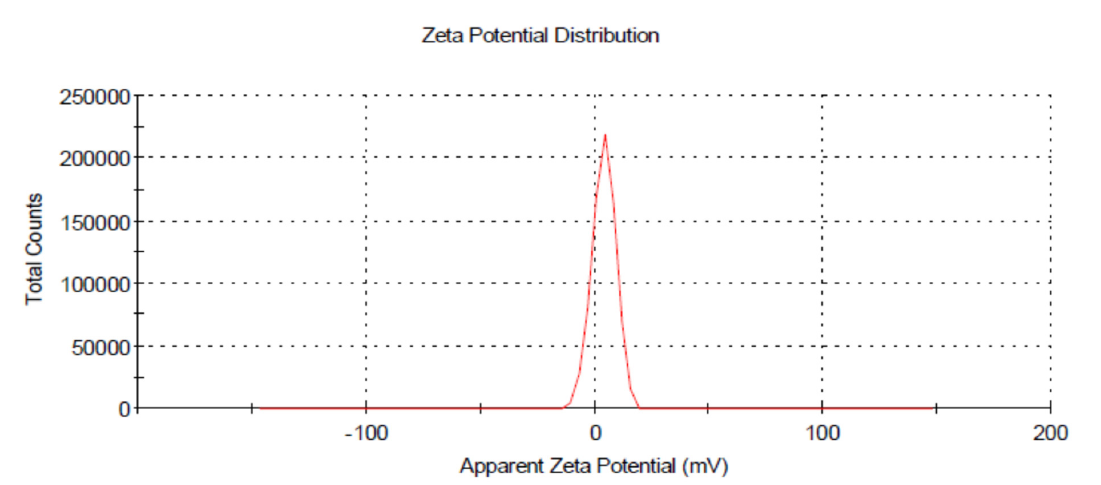
Figure 7. Zeta potential for of Glycyrrhizic acid ammonium salt nanoparticles.